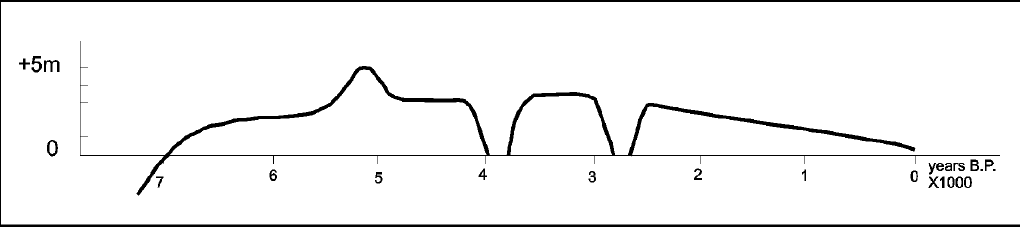
Fig. 3 – The Holocene sea level curve for the coast of Salvador City during the last 7 ky (according to Martin et al. 1979,